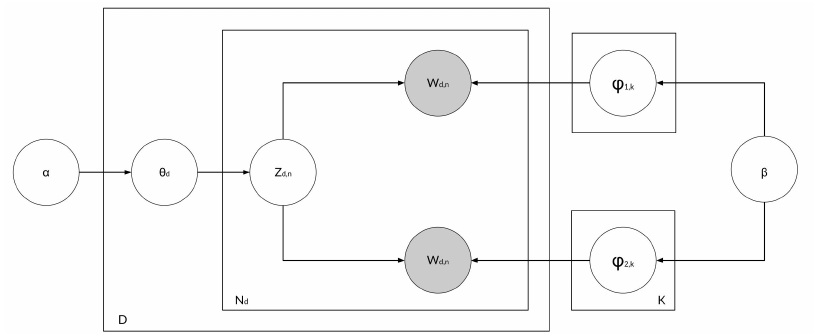
Figure 3. MultiPhiLDA plate notation.